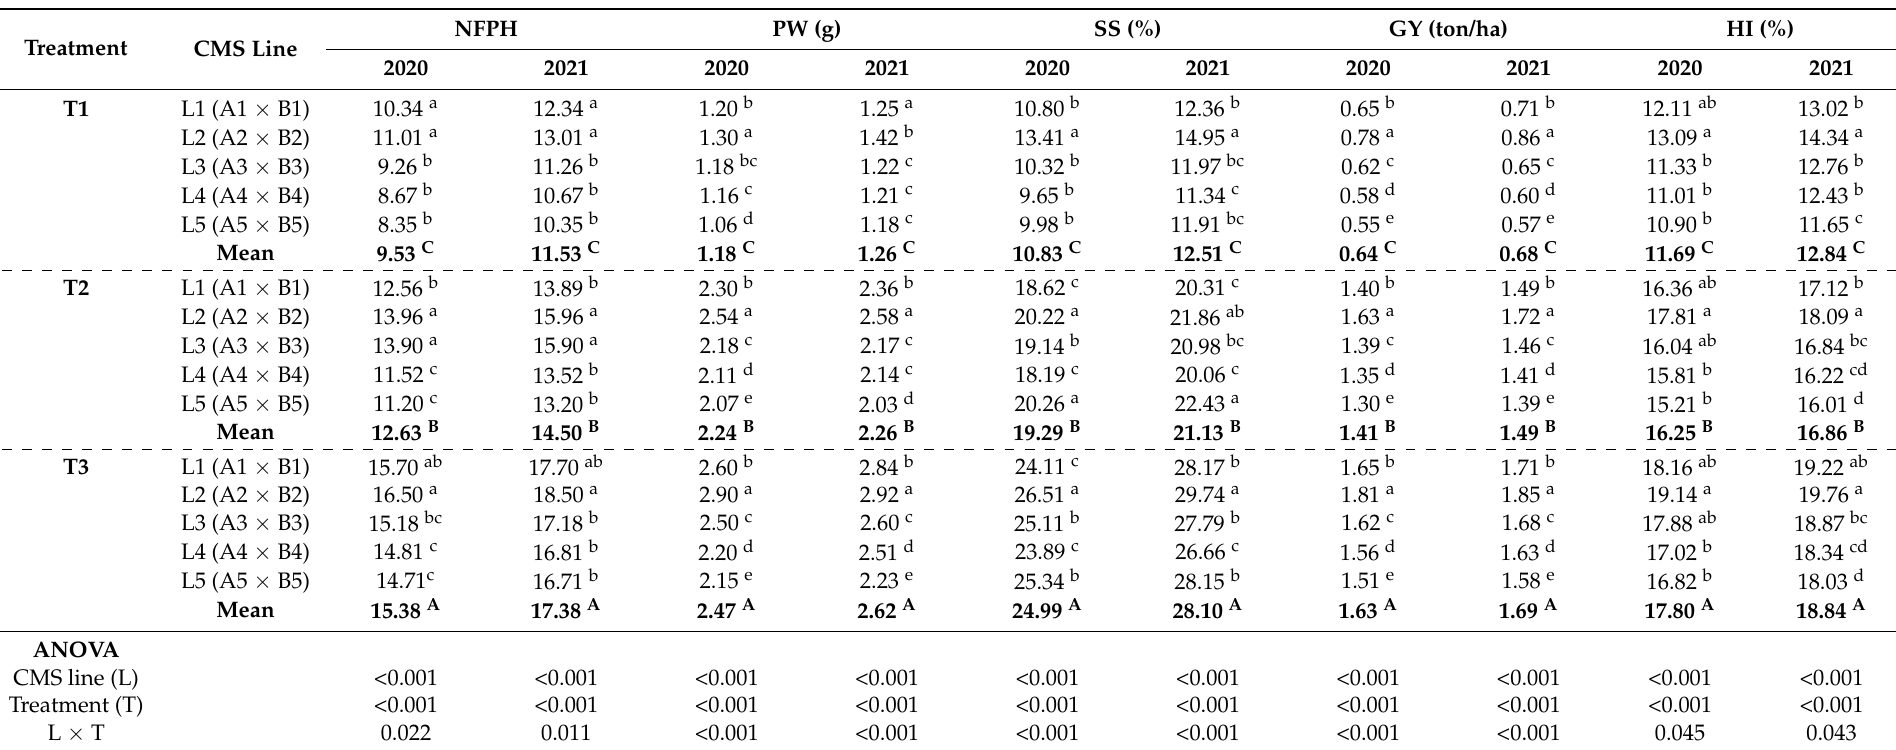
Table 3. Influence of growth regulators on number of fertile panicles per hill (NFPH), panicle weight (PW), seed set (SS), grain yield (GY), and harvest index (HI) of five diverse CMS